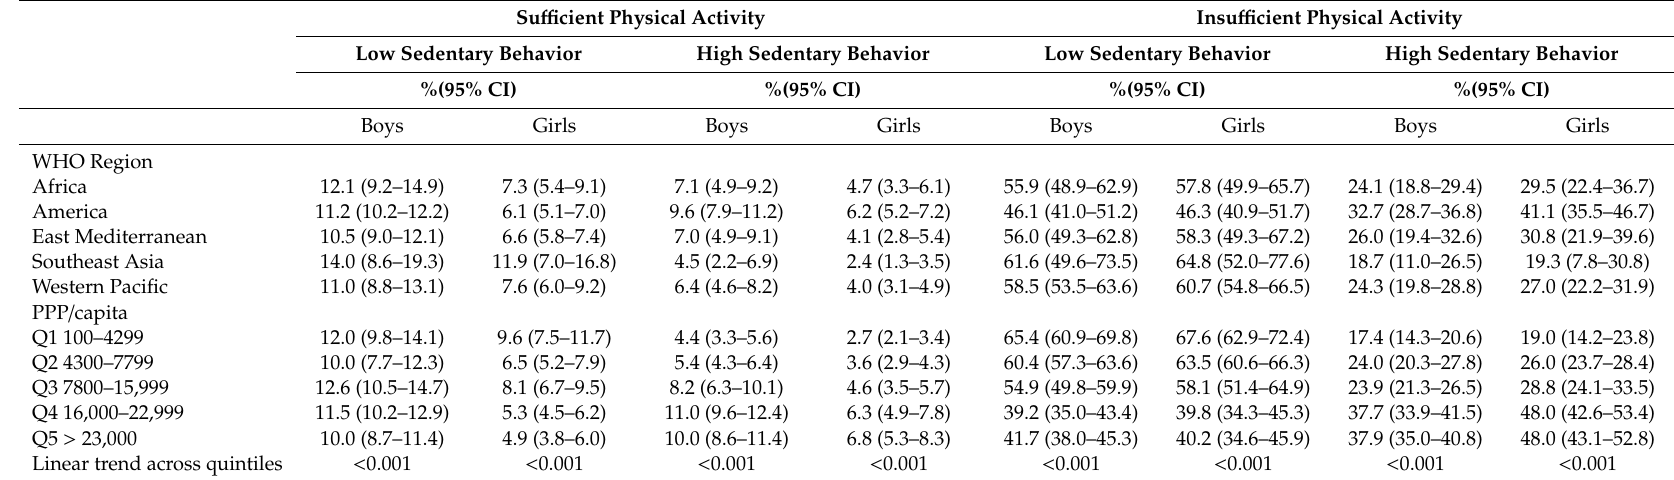
Table 5. Prevalence of combined categories of physical activity and sedentary behavior in adolescents aged 12–15 years by sex, WHO region, and PPP